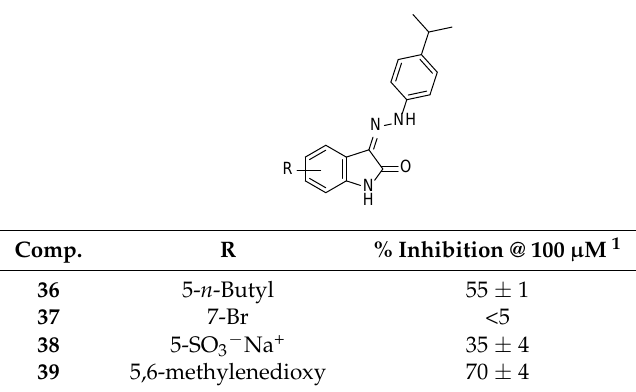
Table 5. A β Antiaggregating Activity of Compounds 36 – 39 .